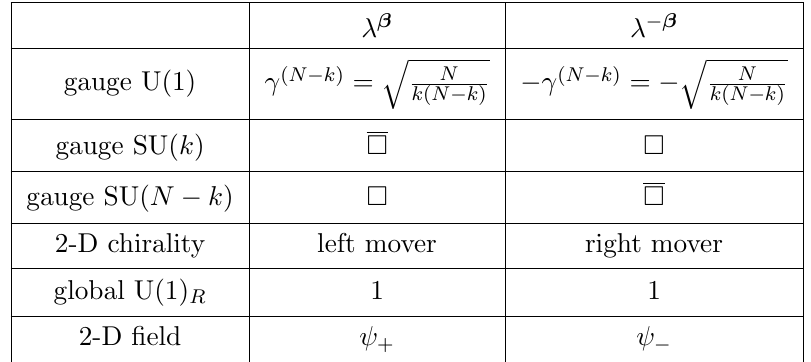
Table 2 . Charges of the fermions (cid:21) (cid:12) (see (2.14)) under the unbroken gauge group on the k -wall. In the bottom two rows, we show the normalizable zero modes’ 2-D chirality and their charge under the anomalous 4-D U(1) R chiral symmetry. The bottom line in the table introduces the 2-D notation for the Weyl fermions of the k -wall theory, see also eq.